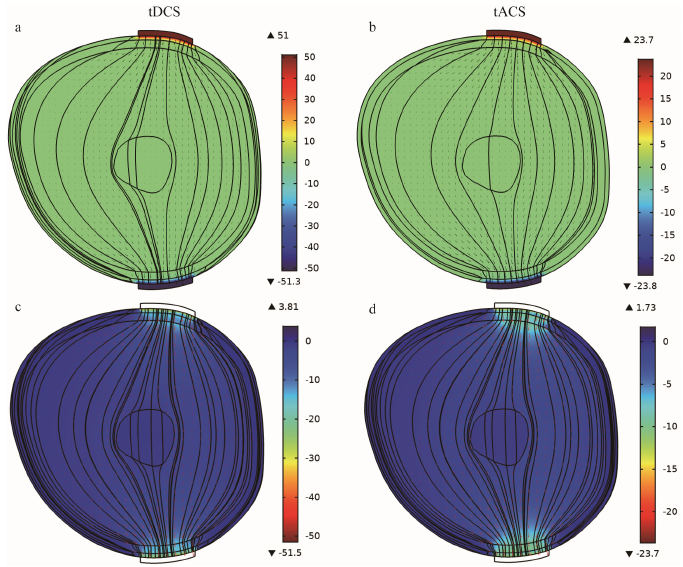
Figure 4. Potential distribution diagram on the cross section. ( a , b ) Coupling potential distribution of DC and AC stimulation on the cross section, respectively. ( c , d ) Current density distribution of DC and AC stimulation on the cross section,